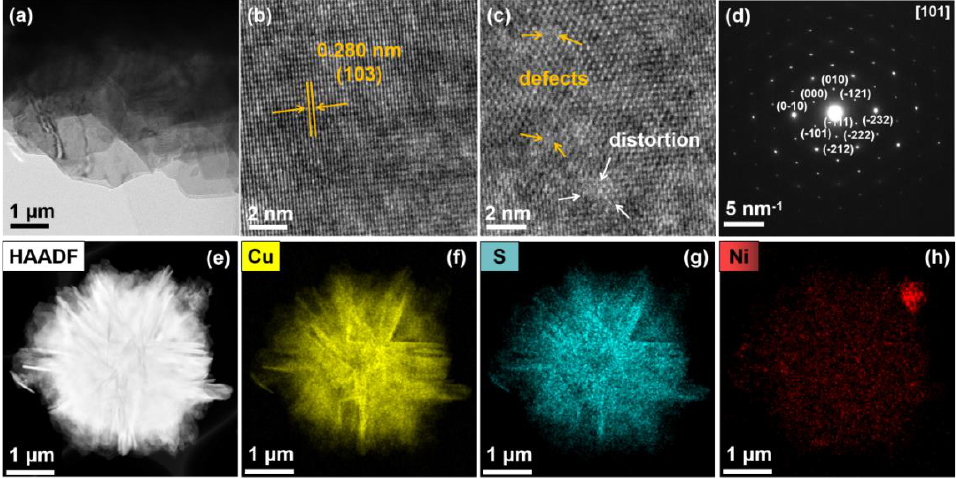
Figure 2. ( a ) TEM image, ( b ) HRTEM image of nanosheets, ( c ) partial enlarged HRTEM image, ( d ) SAED pattern, ( e ) HAADF−STEM image and ( f − h ) the EDX elemental−mapping images of ( d ) SAED pattern, ( e ) HAADF—STEM image and ( f – h ) the EDX elemental—mapping images of Ni 0.1 Cu 0.9 S nanoflower. Ni 0.1 Cu 0.9 S